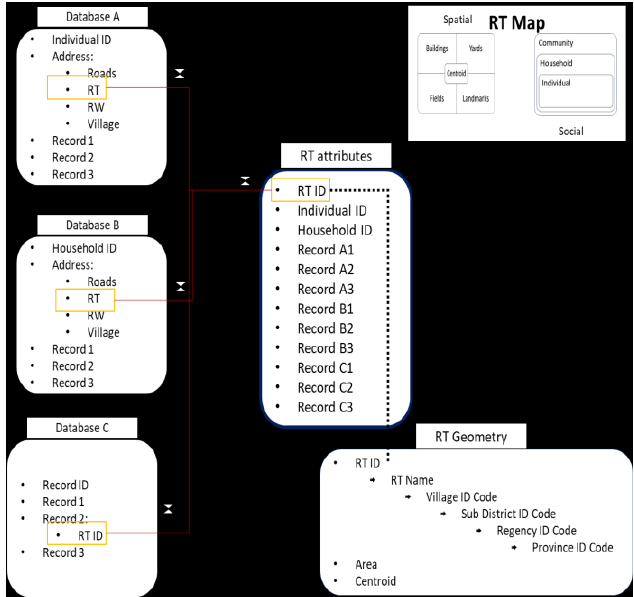
Fig. 12. Data model used for linking the databases and the base map.